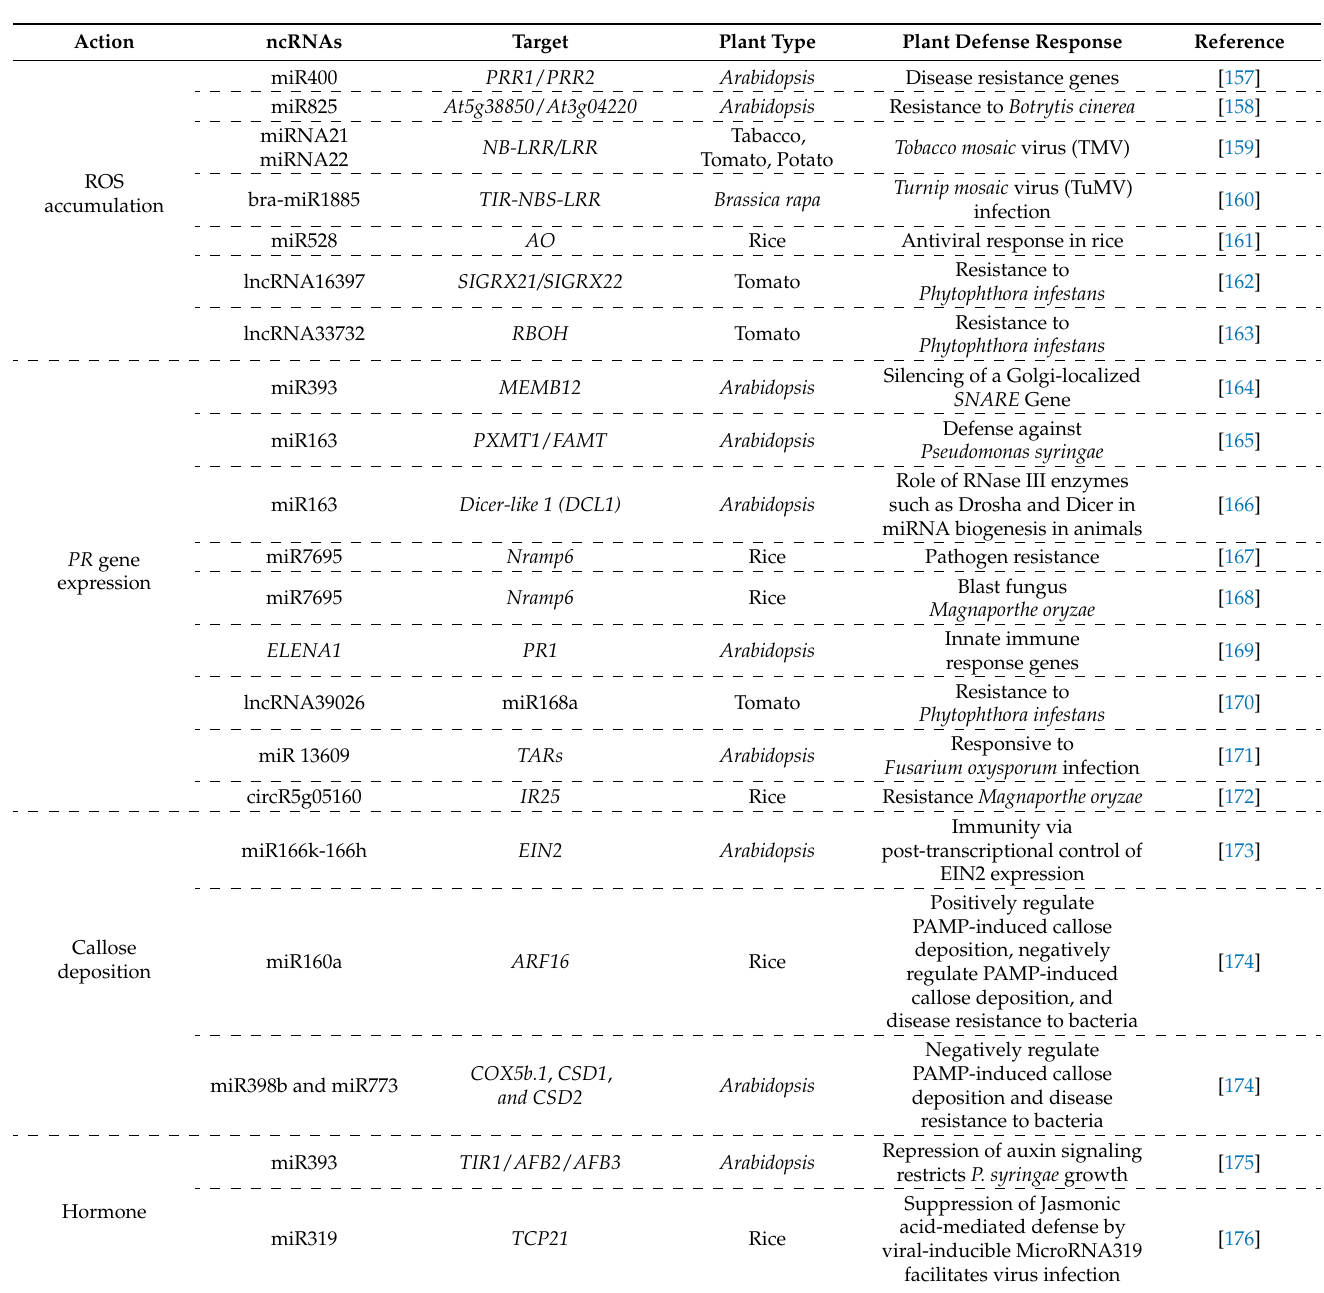
Table 1. ncRNAs involved in plant immune